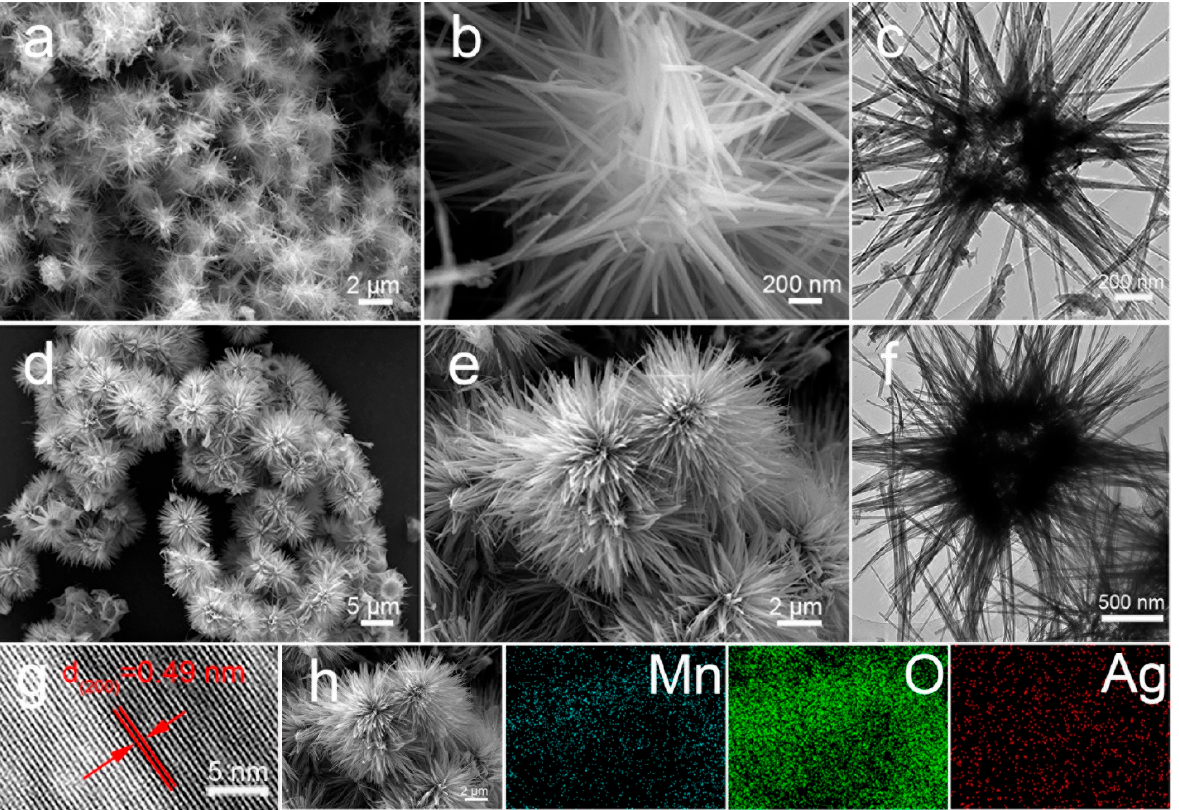
Figure 2. ( a , b ) FESEM image of pure MnO 2 . ( c ) TEM image of pure MnO 2 . ( d , e ) FESEM image of 5%Ag-MnO 2 . ( f ) TEM image of 5%Ag-MnO 2 . ( g ) High-resolution TEM image of 5%Ag-MnO 2